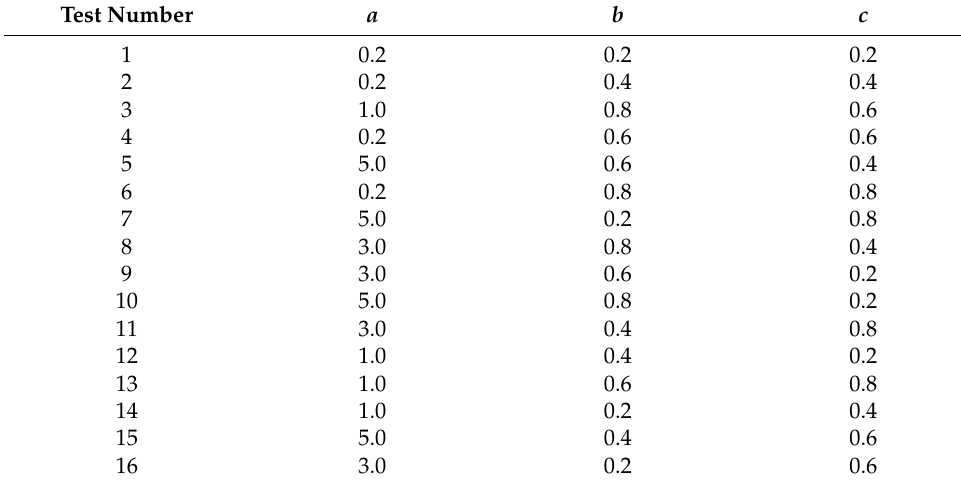
Table 5. Calculation scheme of orthogonal tests under single